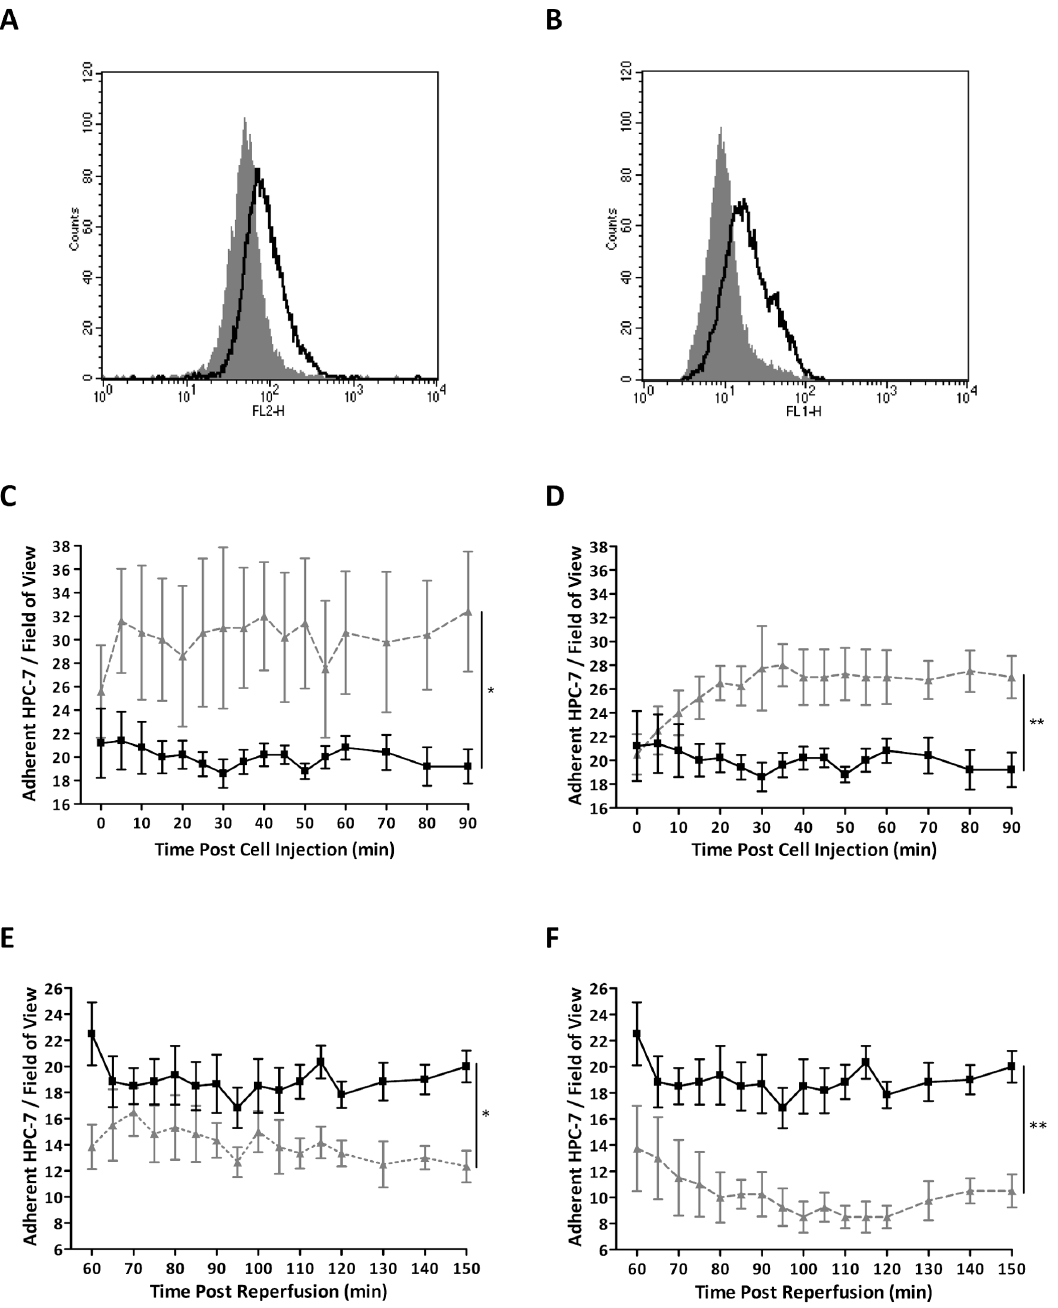
Figure 3. KC and SDF-1 a mediate HPC-7 recruitment to the healthy and IR injured kidney. HPC-7 expressed the main KC and SDF-1 a receptors, CXCR2 (A) and CXCR4 (B) respectively. Topically treating a healthy kidney with KC [200 ng/ml; C] or SDF-1 a [200 ng/ml; D] for 4 hours led to significant HPC-7 recruitment compared to the PBS control. Blocking CXCR2 (E) and CXCR4 (F) on HPC-7 prior to administration also decreased HPC-7 adhesion in vivo within the IR injured kidney. For all figures: PBS controls = solid line; kidney pre-treatments/mAb treated HPC-7= dashed line. Results are presented as mean 6 SEM (n $ 4). *p , 0.05, **p , 0.01.